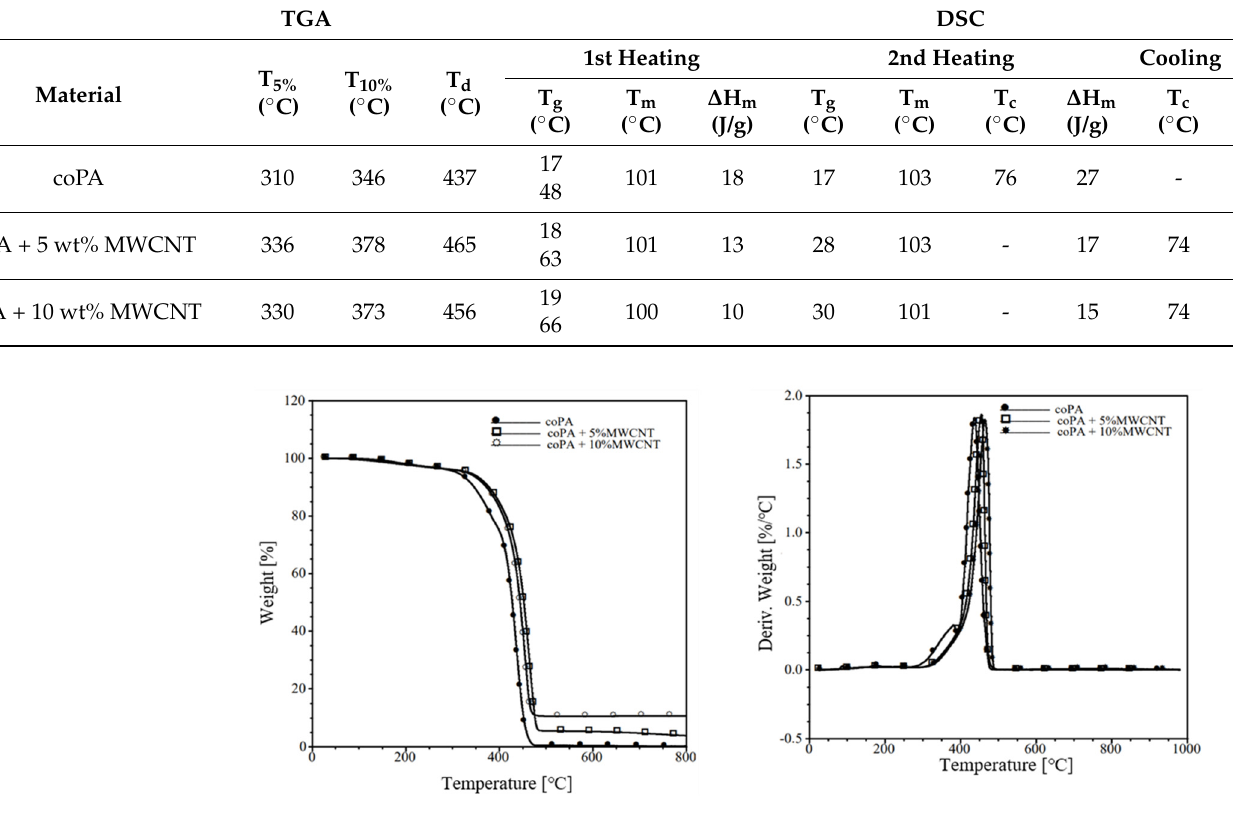
Figure 5. The TGA curves for the neat coPA and its masterbatches containing 5 wt% and 10 wt% MWCNT.